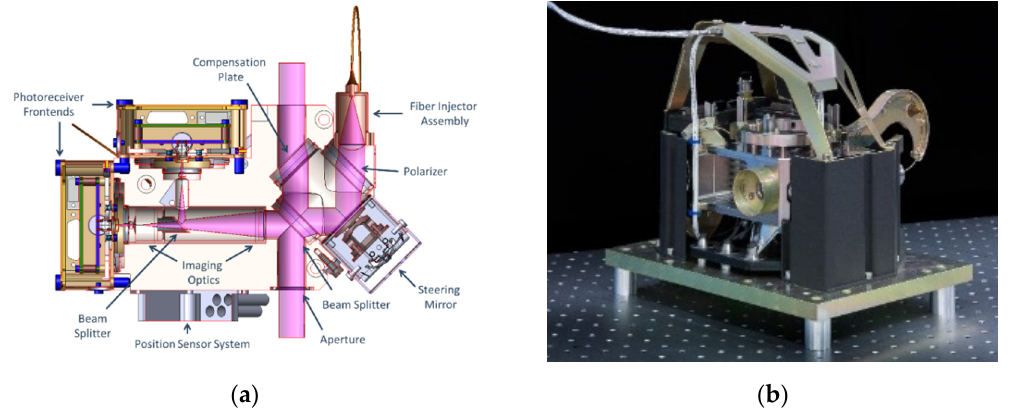
Figure 8. Optical bench of GRACE FO. ( a ) Cross-sectional view of the optical bench; ( b ) optical bench flight spare.